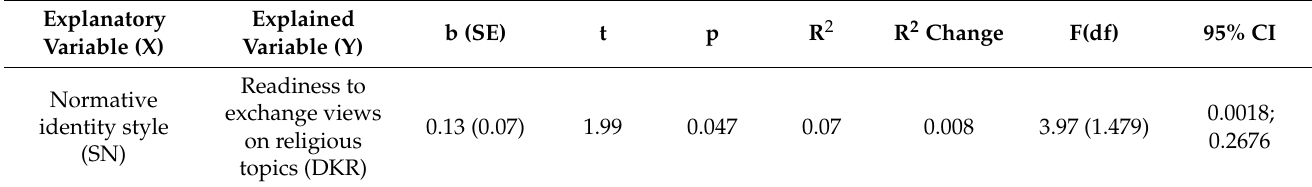
Table 3. Organized religiousness as a moderator of the relationships between identity styles and readiness to enter into interreligious dialogue.